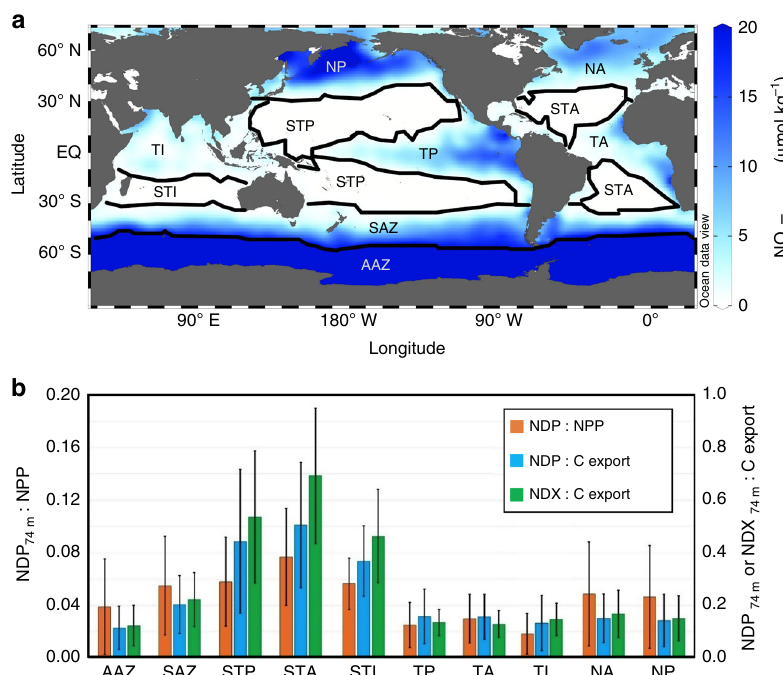
Fig. 4 Regional variability of DOC production and export to NPP and C export. a Distribution of depth-integrated mean of nitrate above 74 m, which is used to regionalize the global ocean into distinct regions (solid borderlines): Antarctic Zone (AAZ), Sub-Antarctic Zone (SAZ), Sub-Tropical Paci fi c (STP), Atlantic (STA), and Indian (STI), and Tropical Paci fi c (TP), Atlantic (TA), and Indian (TI), and North Paci fi c (NP) and Atlantic (NA). b Ratio of regionally averaged NDP and NDX fl uxes to satellite-derived net primary productivity (NPP) and C export fl uxes for the regions shown in panel a . Error bars in b indicate ± 1 standard deviation